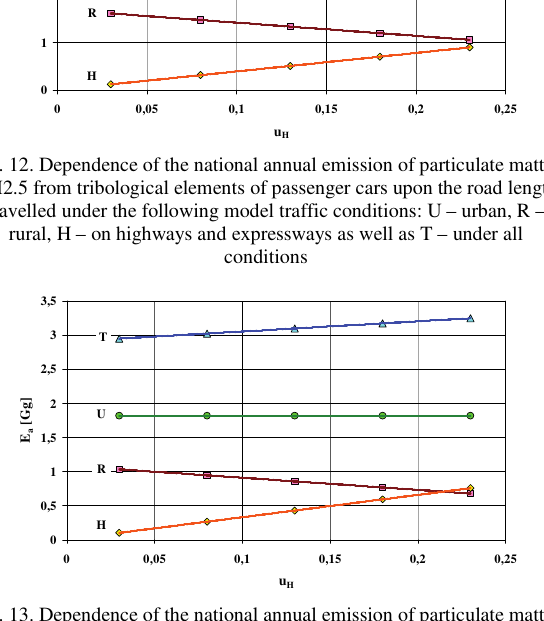
Fig. 13. Dependence of the national annual emission of particulate matter from the exhaust system of passenger cars engines cars upon the road length travelled under the following model traffic conditions: U – urban, R – rural, H – on highways and expressways as well as T – under all